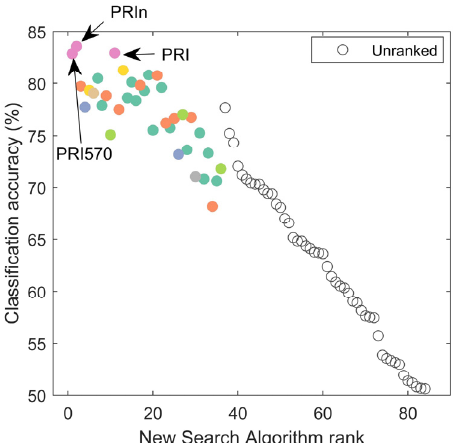
Figure 8. Identified VIs (ranked on the x -axis) based on the new search algorithm for most informative VI. Spearman’s rank test rho is − 0.75. Unranked VIs did not meet the minimum criteria of BD i > median (BD) and p i < median( p ). Colors were used for VI groupings and are the same as in Figure 7. Noteworthy indices are indicated with arrows and labels; these indices had the highest classification accuracies.